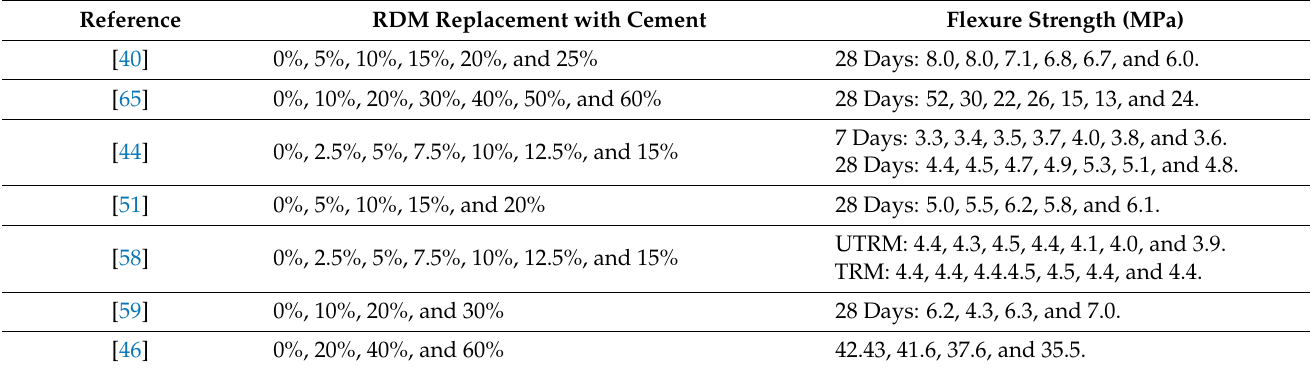
Table 3. Summary of Flexural strength.